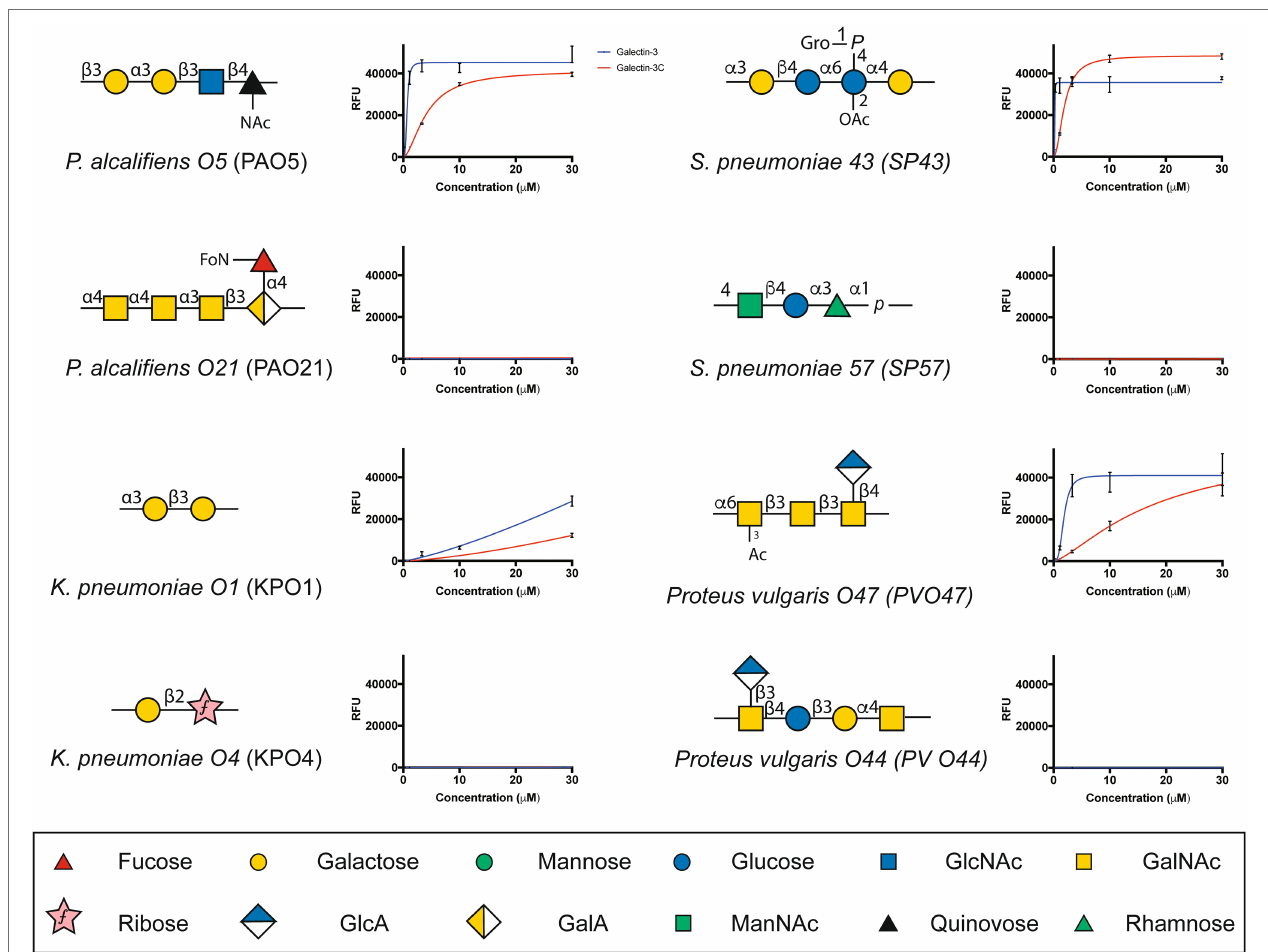
FIGURE 5 | Gal-3 and Gal-3C exhibit high affinity interactions with select microbial glycans. The binding isotherms of Gal-3 (blue) and Gal-3C (red) for microbial glycans are shown. The structure for each corresponding glycan is depicted on the left of each binding isotherm. Symbols used to represent each monosaccharide present in each bacterial glycan are represented in the legend below. Error bars represent means ± standard deviation (SD). GlcA: D-Glucuronic acid, GalA: D-Galacturonic acid and ManNAc: